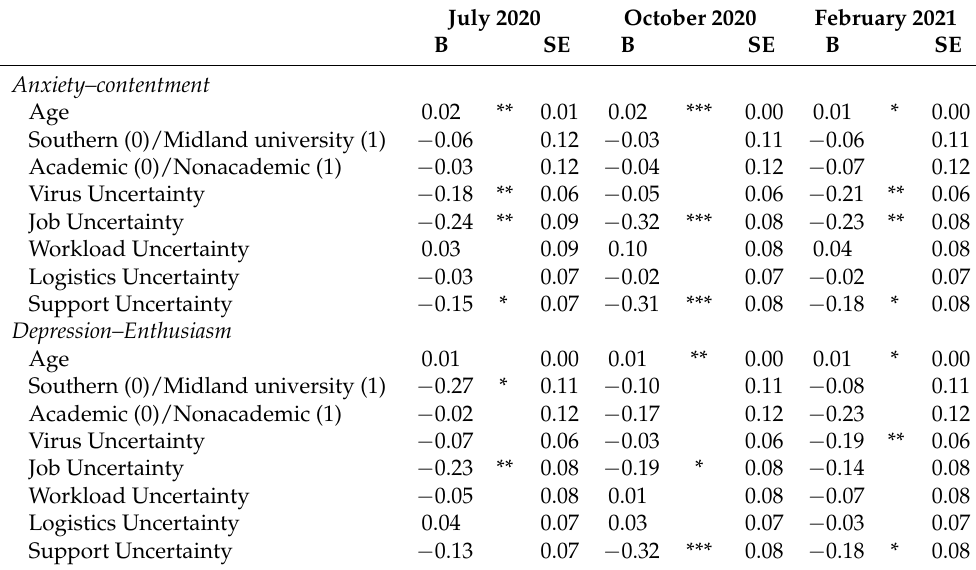
Table 4. Effects of uncertainty on well-being (Hypothesis